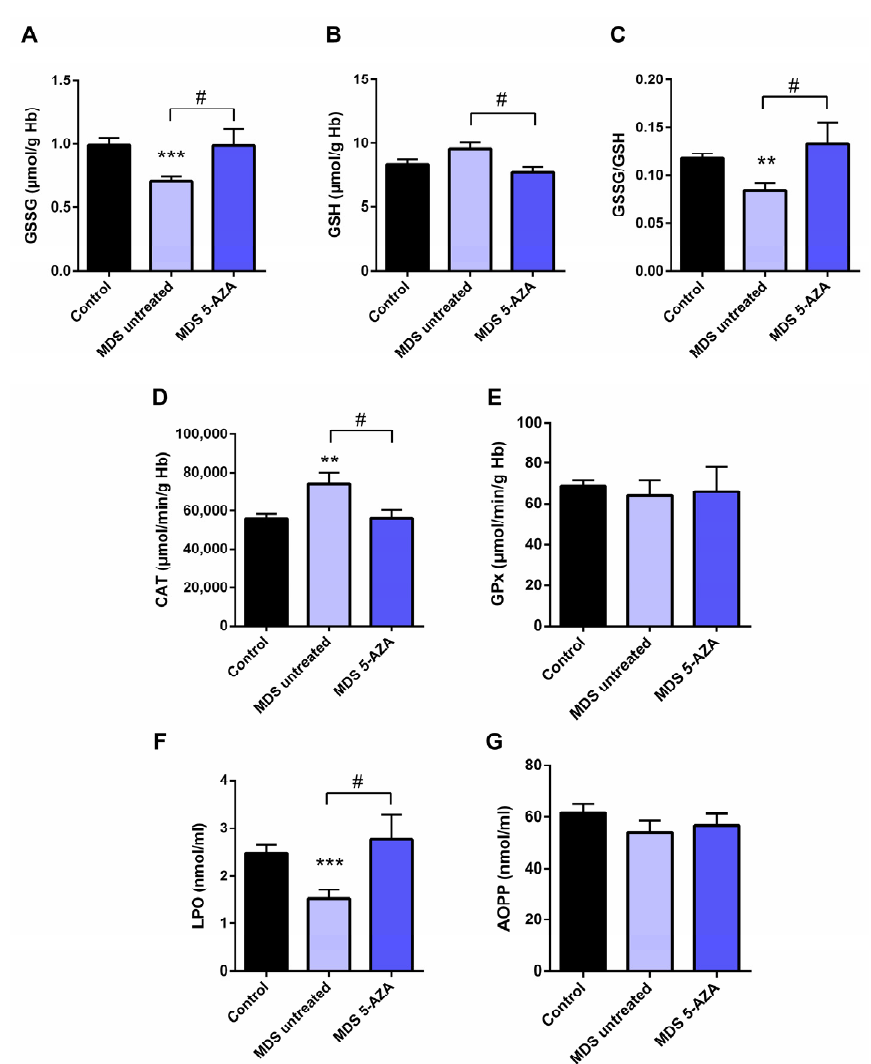
Figure 1. Analysis of erythrocyte and plasmatic oxidative stress parameters in myelodysplastic syndrome (MDS) patients and controls. MDS patients were divided at diagnosis or only with supportive care (untreated MDS) or MDS patients treated with 5-azacitidine (5-AZA MDS). The following oxidative stress levels are represented: ( A ) erythrocyte levels of oxidized glutathione (GSSG); ( B ) reduced glutathione (GSH); ( C ) GSSG · GSH − 1 ratio; ( D ) catalase (CAT) and ( E ) glutathione peroxidase (GPx) activity; ( F ) lipid peroxidation (LPO) and ( G ) advanced oxidation protein products (AOPP) plasma levels. Data are presented as mean ± SEM. ** p < 0.01, *** p < 0.001 vs. control; # p < 0.05 vs. 5-AZA MDS group.